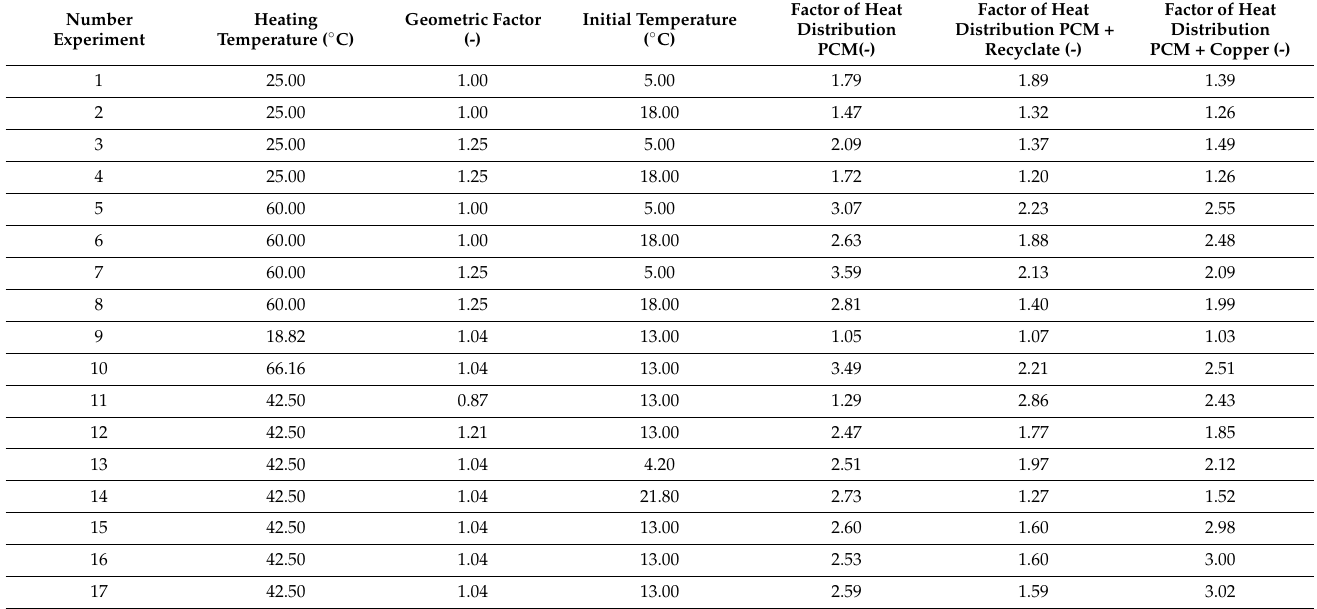
Table 7. Summary of input and output quantities for three different types of phase-change heat accumulators, according to the experimental